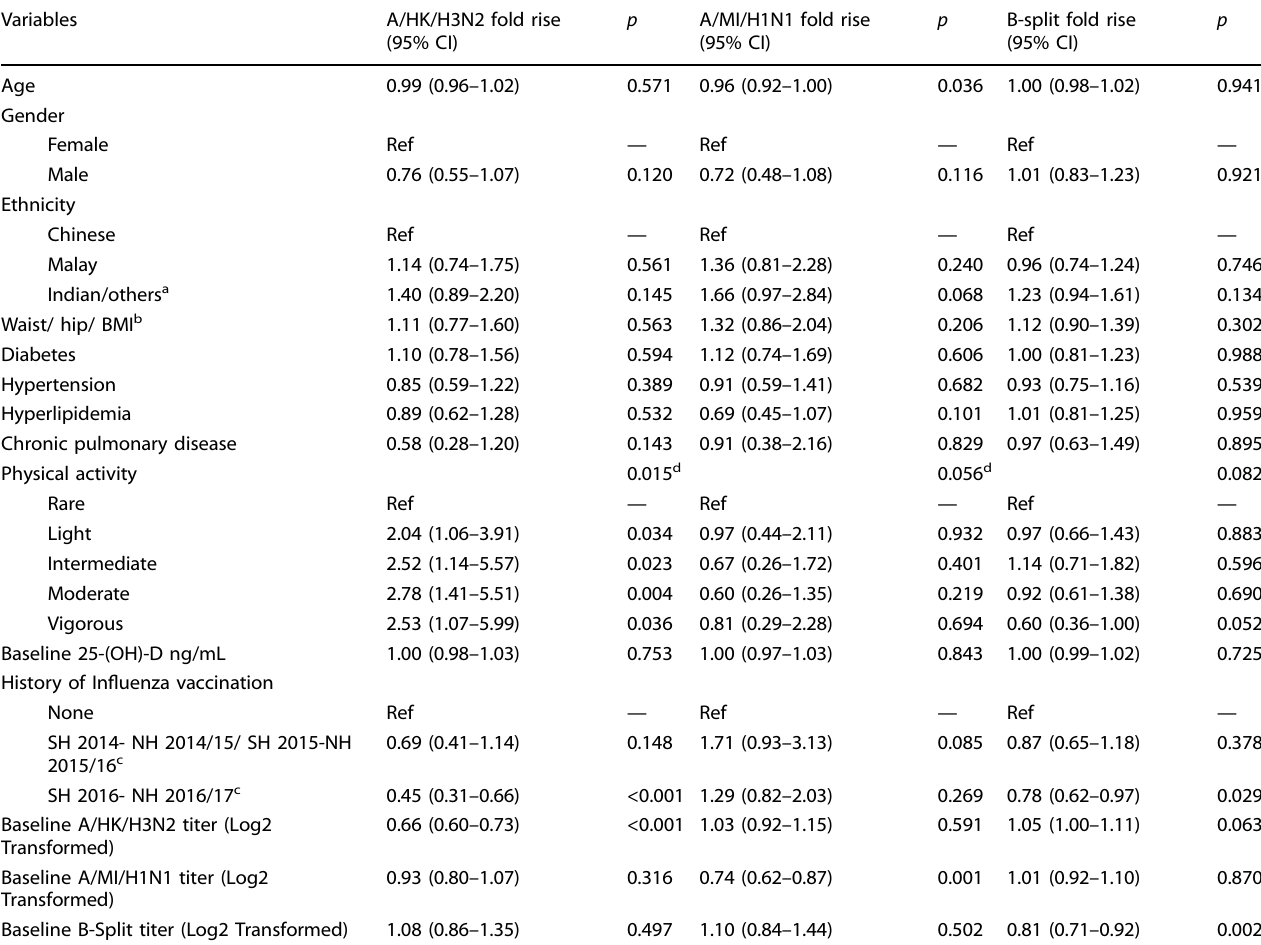
Table 2. Multivariable regression analyses of factors associated with A/HK/H3N2, A/MI/H1N1, and B HAI fold rise at D28 compared to D0.